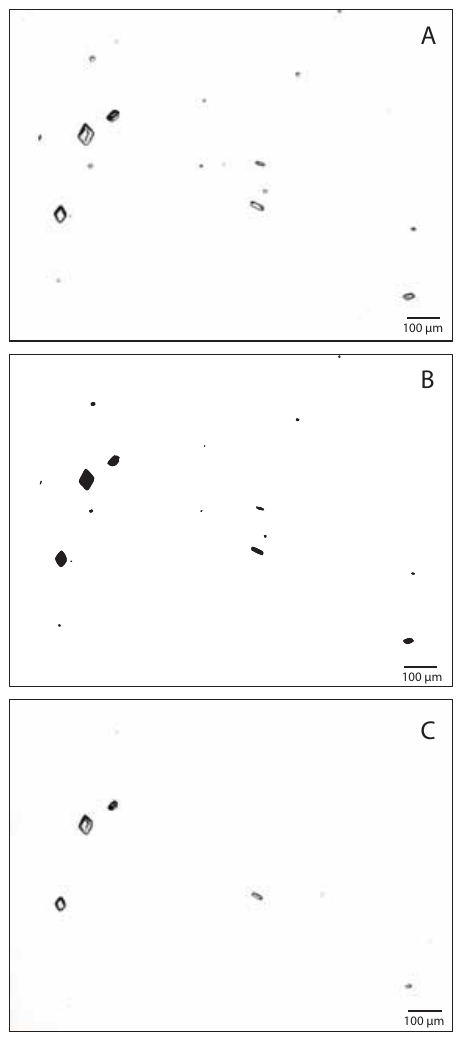
Fig. 5. Microscopic images of ikaite crystals (A) a few seconds af- ter melting 50mg sea ice (10–20cm section) from POLY I. Image represents a very small fraction (2µg) of the sample. (B) Software (ImageJ 1.45s) processing of image A to find the number (19) and area (0.48% of counting area) of the crystals. (C) Image taken after 2min showing that crystals are dissolving.